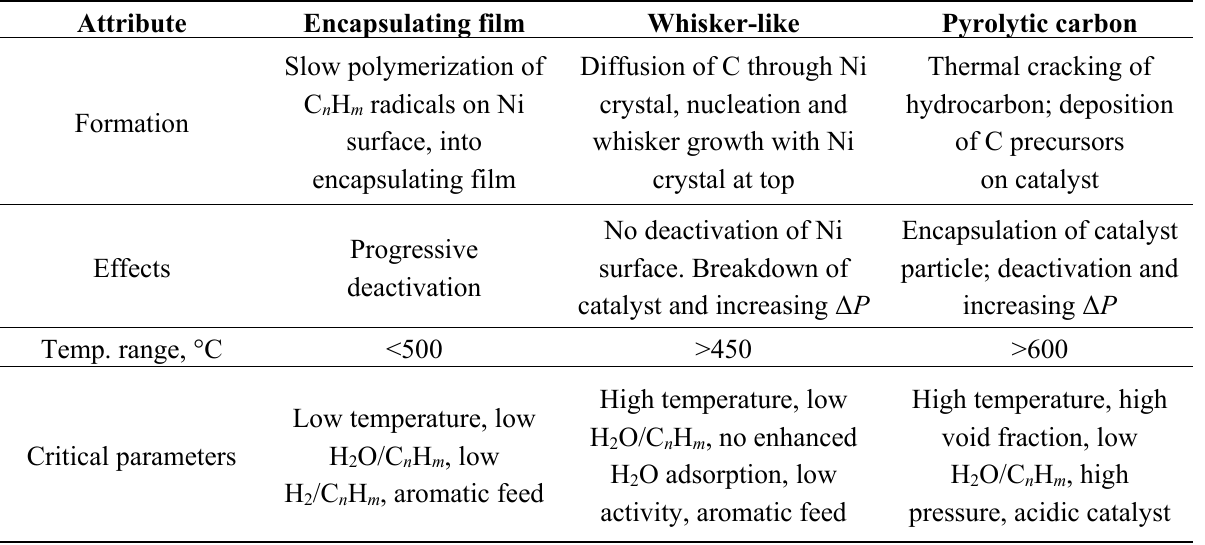
Table 7. Carbon Species Formed in Steam Reforming of Hydrocarbons on Nickel Catalysts a